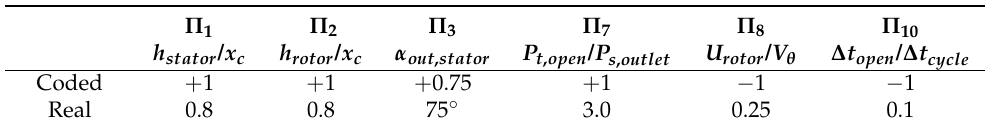
Table 6. Factors optimizing the turbine performance indicator in the experimental domain (cid:16) (cid:17) η cycle , max = 30.1%